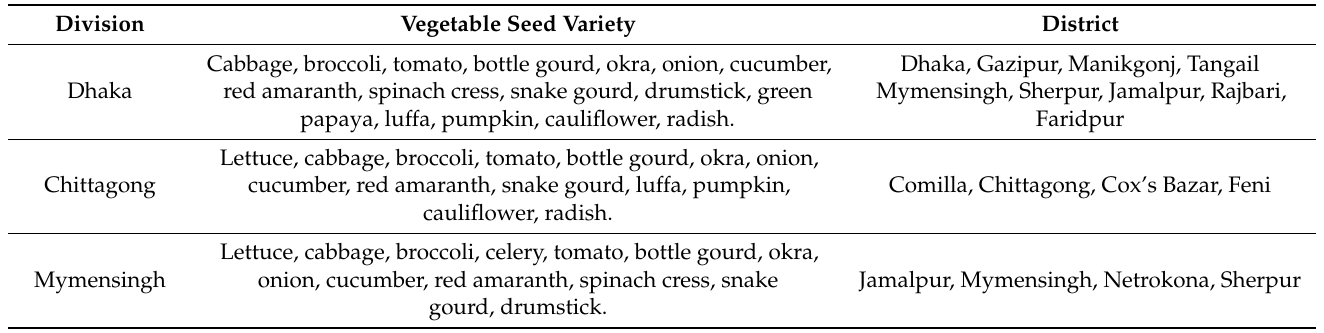
Table 1. Bangladesh’s main production sites for varied vegetable seeds.